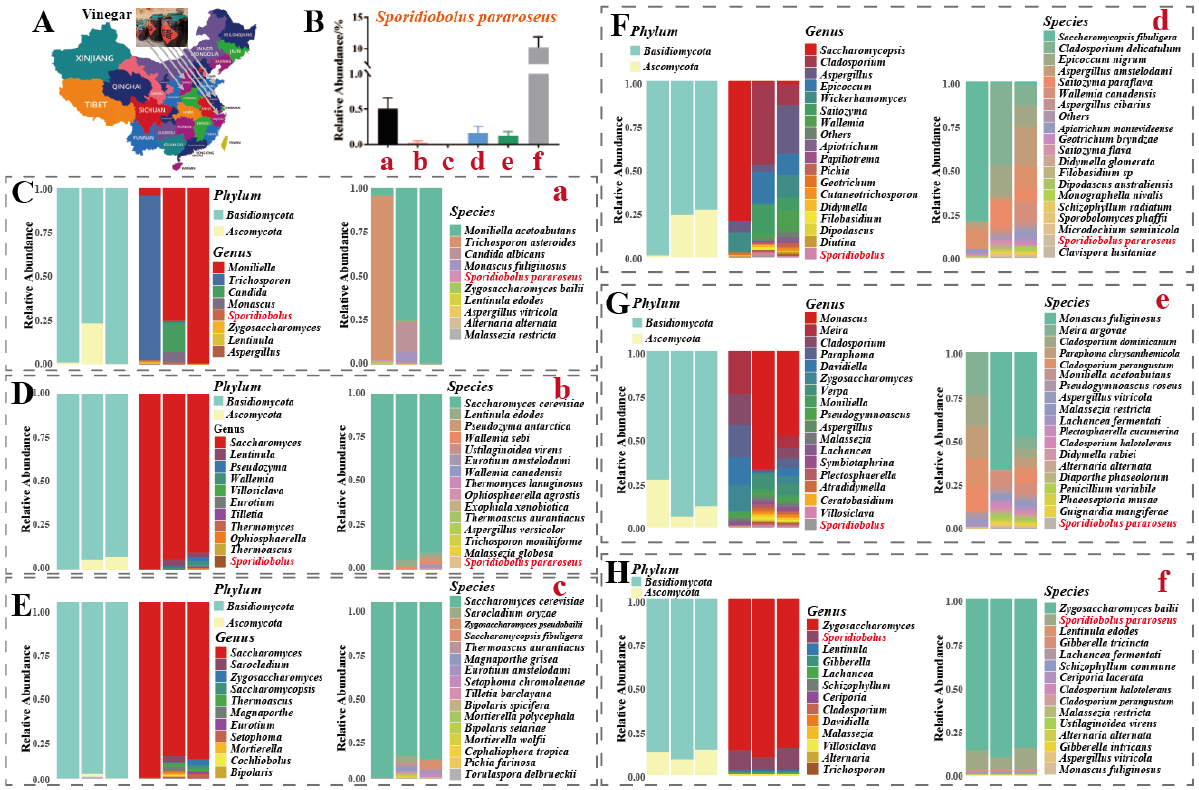
Figure 1. Source and distribution of Sporidiobolus pararoseus in vinegar. ( A ) Sampling map of vinegar samples. ( B ) Relative abundance of S. pararoseus in vinegar samples. ( C – H ) ITS sequencing results of six vinegar samples.